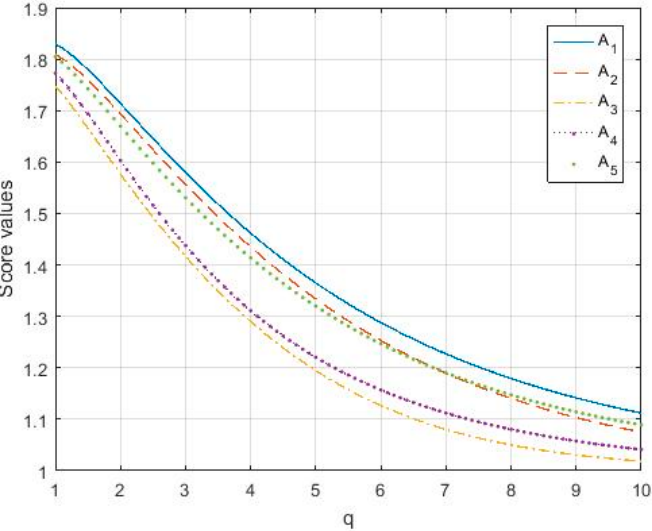
( ) ∈ 1,10 q based on the q- RPFDWHM operator. Figure 1. Score values of the alternatives when q ∈ ( 1,10 ) based on the q -RPFDWHM